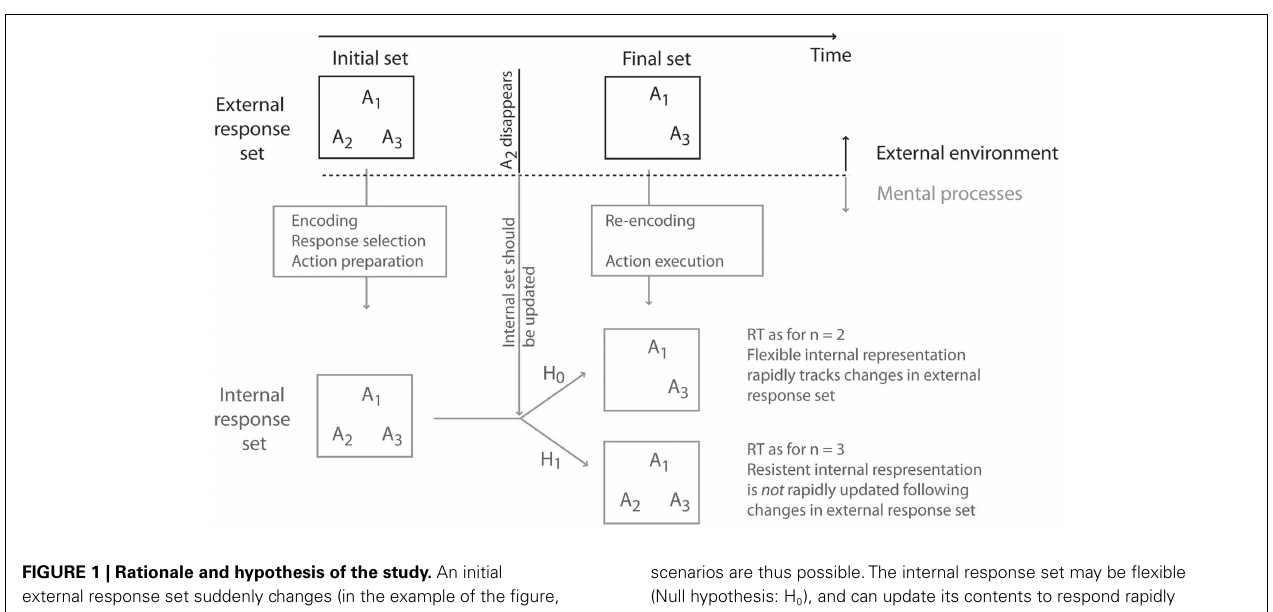
FIGURE 1 | Rationale and hypothesis of the study. An initial external response set suddenly changes (in the example of the figure, response alternative A2 suddenly becomes unavailable). In these cases, the internal representation of the response alternatives must be updated to reflect the changes in the external environment.Two